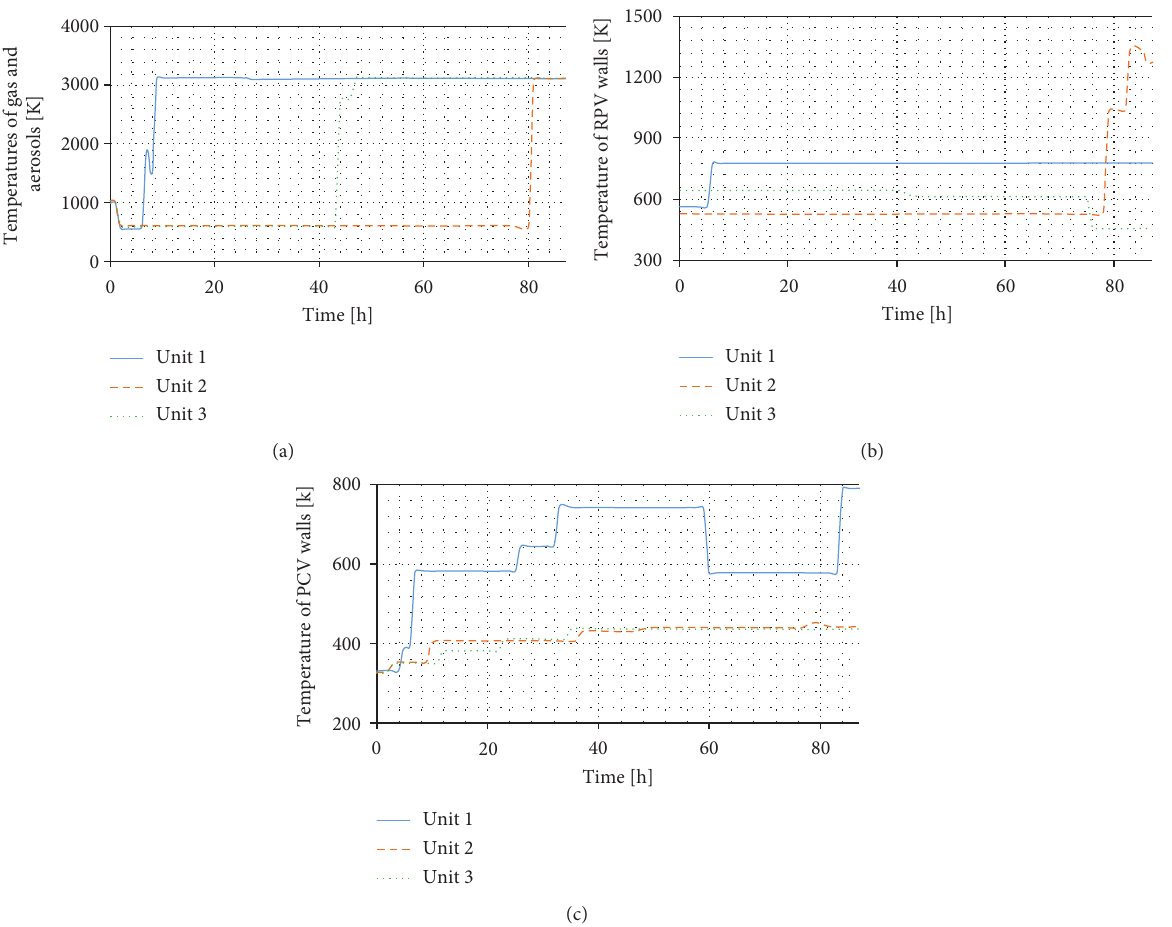
Figure 3: Conditions of the temperatures of Units 1–3 for Modified ART Mod 2 code: (a) gas and aerosols, (b) the RPV walls, and (c) the PCV